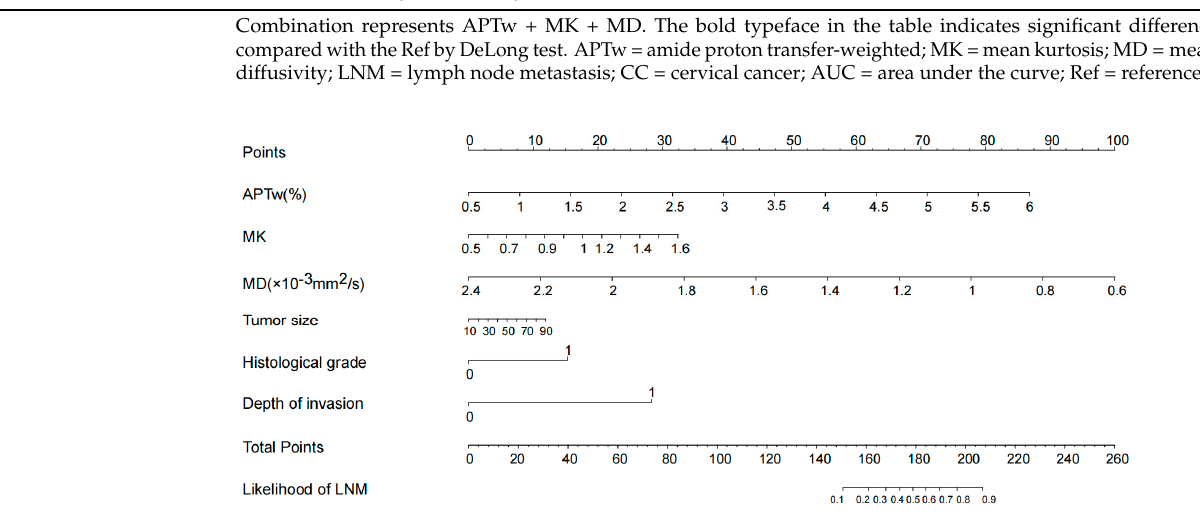
Figure 6. Receiver operating characteristic curves (ROC) analysis of each parameter for predicting the LNM in patients with cervical cancer. The area under curves (AUCs) of amide proton transfer- weighted (APTw), mean kurtosis (MK), mean diffusivity (MD) values, and combination model (APTw + MK + MD) to evaluate LNM status were 0.807 (95% CI: 0.686–0.897), 0.715 (95% CI: 0.585–0.823), 0.675 (95% CI: 0.543–0.790), and 0.864 (95% CI: 0.752–0.938), respectively. The combi- nation of APTw, MK, and MD yielded the highest AUC.